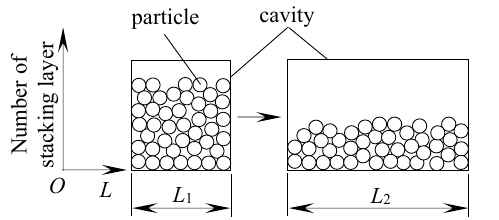
Figure 21. Influence of L on stacking